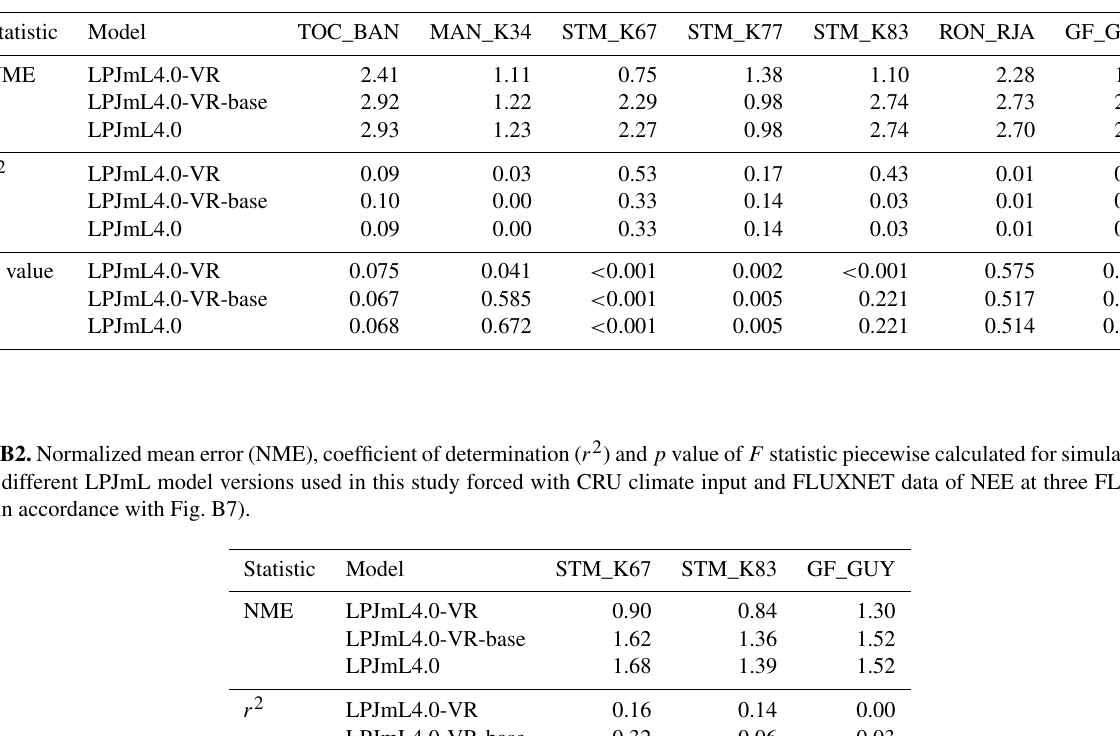
Table B1. Normalized mean error (NME), coefficient of determination ( r 2 ) and p value of F statistic piecewise calculated for simulated ET of the different LPJmL model versions used in this study forced with CRU climate input and FLUXNET data of ET at seven FLUXNET sites (in accordance with Fig. B6).